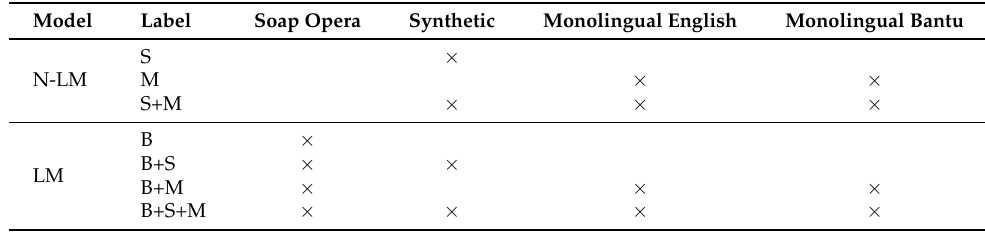
Table 4. Corpora considered for the different pretraining or augmentation strategies, where × indicates corpora included in the respective